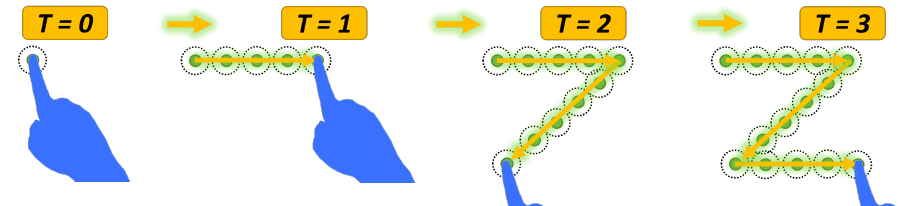
Figure 3. The proposed framework allows recording gestures by storing the spatial path of the desired hand joints as 3D points and represents them as spheres. To help the user redo the desired gesture, a visual path is shown (can be customized or disabled), which the hand joints should